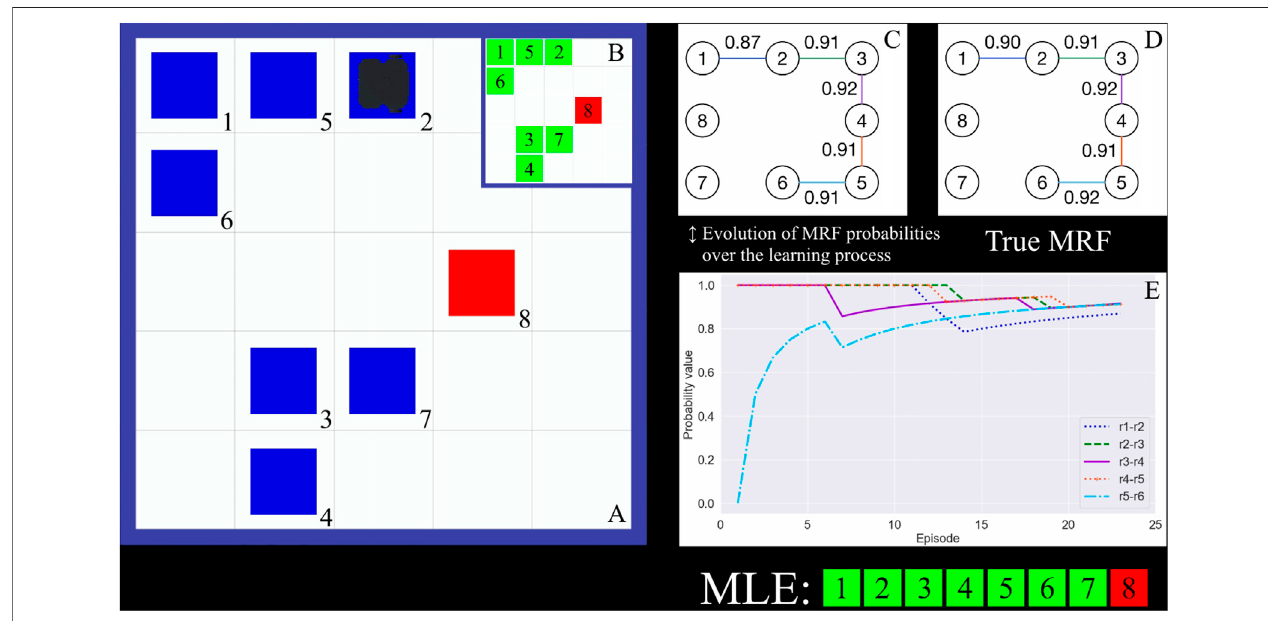
FIGURE 7 | (A) Instance of the rocksample environment in which the TurtleBot acts during episode 23. (B) True rock values in episode 23. (C) MRF learned after 23 episodes. (D) True MRF,the onetobe learned. (E) Evolution ofedgeprobabilityvalues at theend ofepisode 23.When they converge, the learningprocessisended.